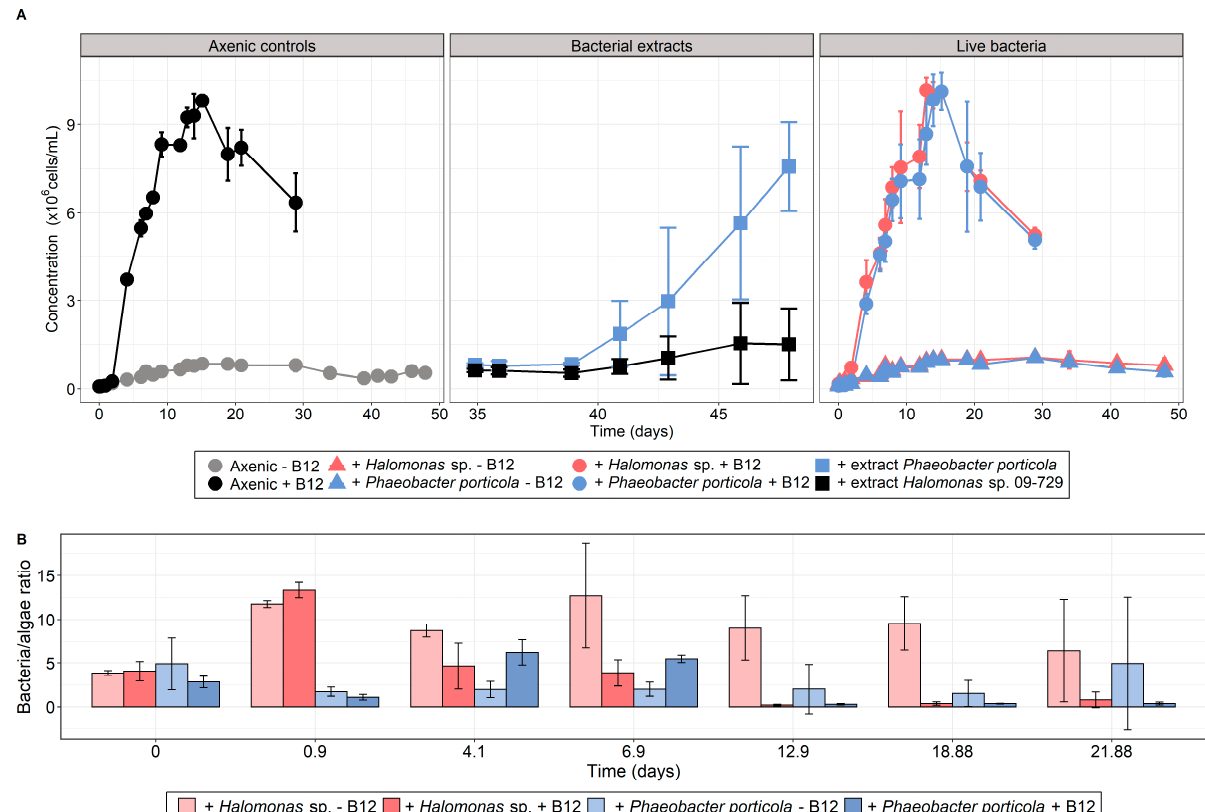
Figure 2. Cultivation experiments of T. lutea with different B 12 sources. ( A ) Growth curves for axenic controls (left panel), with bacterial extracts (center panel), or in co-culture with single live bacterial strains (right panel), with different B 12 availability levels (means of n = 3 biological replicates ± stand- ard deviation of the mean). ( B ) Bacteria/algae ratios for the co-cultures with live bacterial cells with different B 12 availability levels, as above (means of n = 3 biological replicates ± standard deviation of the mean). Table 2. Maximal biomass increase of T. lutea culture experiments with live bacteria or bacterial extracts, with or without cobalamin